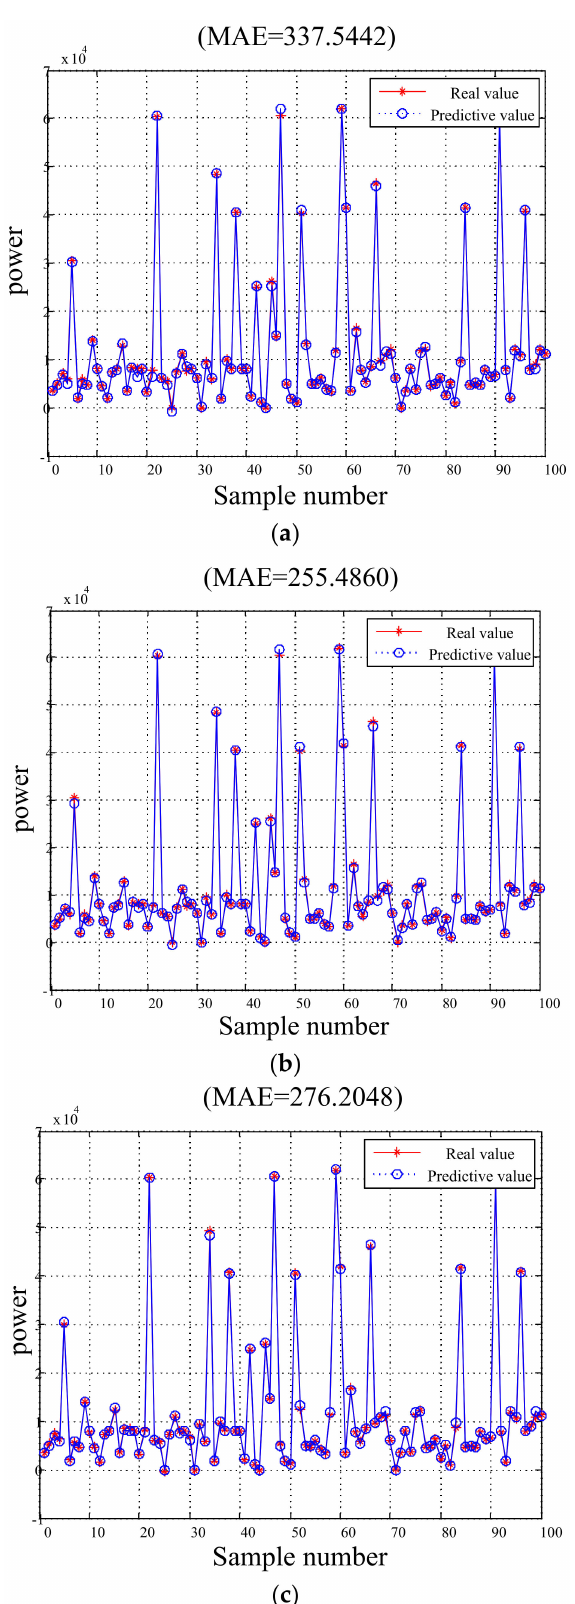
Figure 4. The real value of wind power is compared with the predicted value. ( a ) ELM ( b ) ELM-KMPE ( c ) BP neural